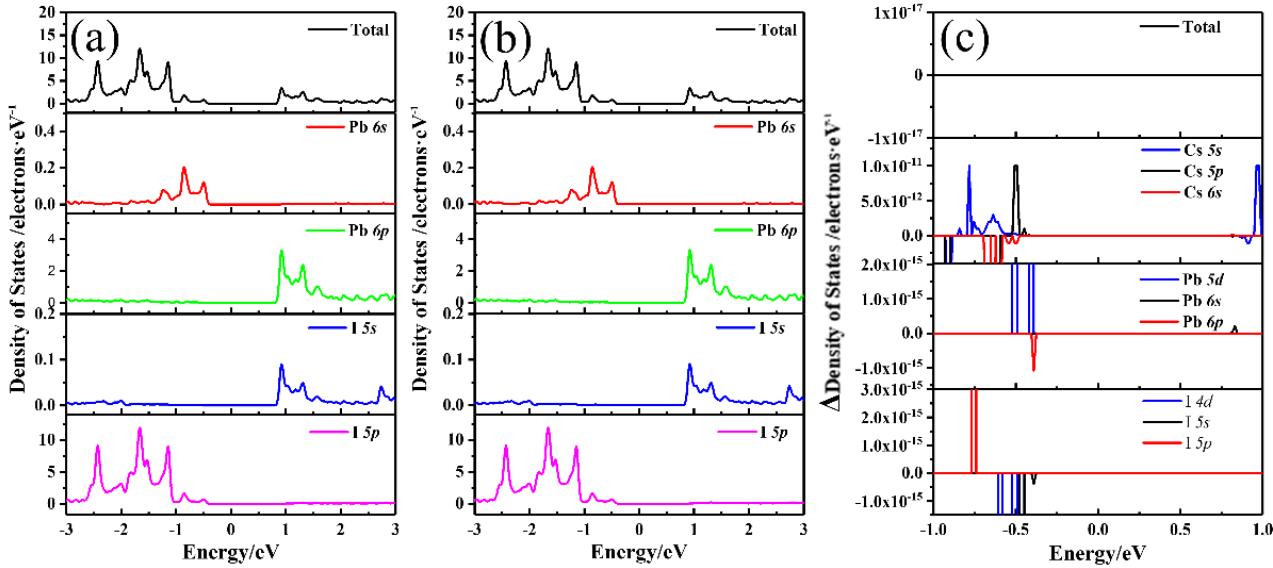
Figure 2. The DOS of perovskite CsPbI 3 under different pressure. ( a ) 0 kPa. ( b ) 10 kPa. ( c ) The DOS difference between 0 and 10 kPa.